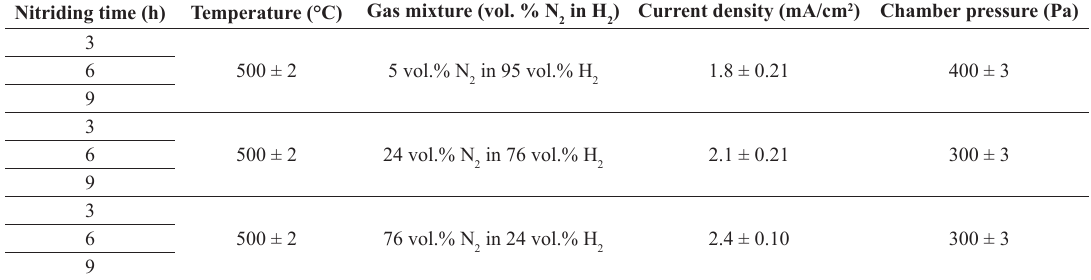
Table 2. Parameters used for plasma nitriding of samples using three different nitrogen gas